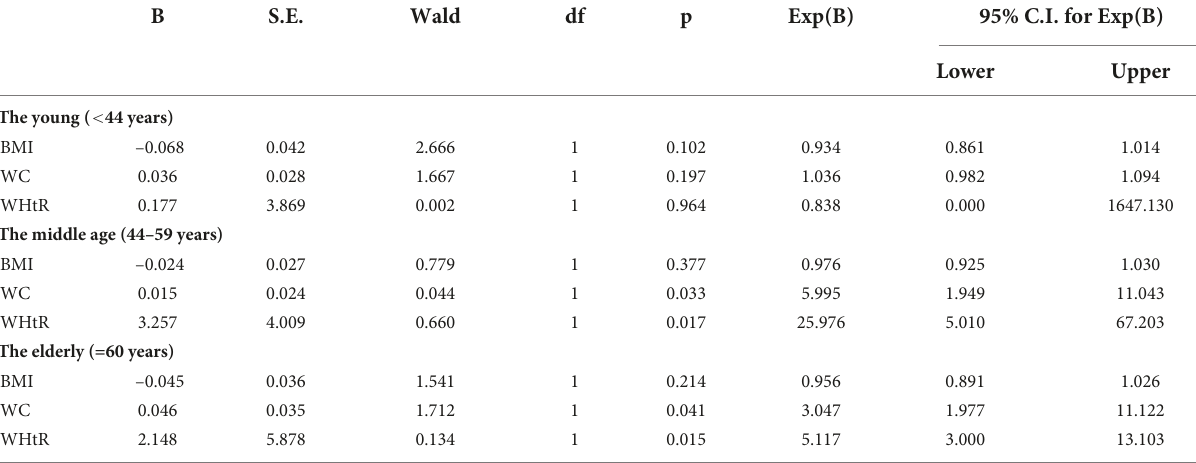
TABLE 4 Logistic regression showing odds ratio of obesity indices for peripheral neuropathy by